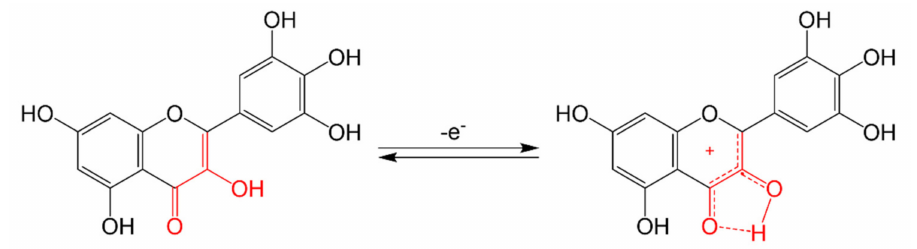
Figure 4. Antioxidation mechanism of C3 and/or C5-OH flavones. Ferric ion chelators prevent the binding of iron to components of the membrane and prevent the precipitation of Fe(OH) 3 ; this process avoids hydroxyls radicals or peroxides formation (Figure 5) [120].